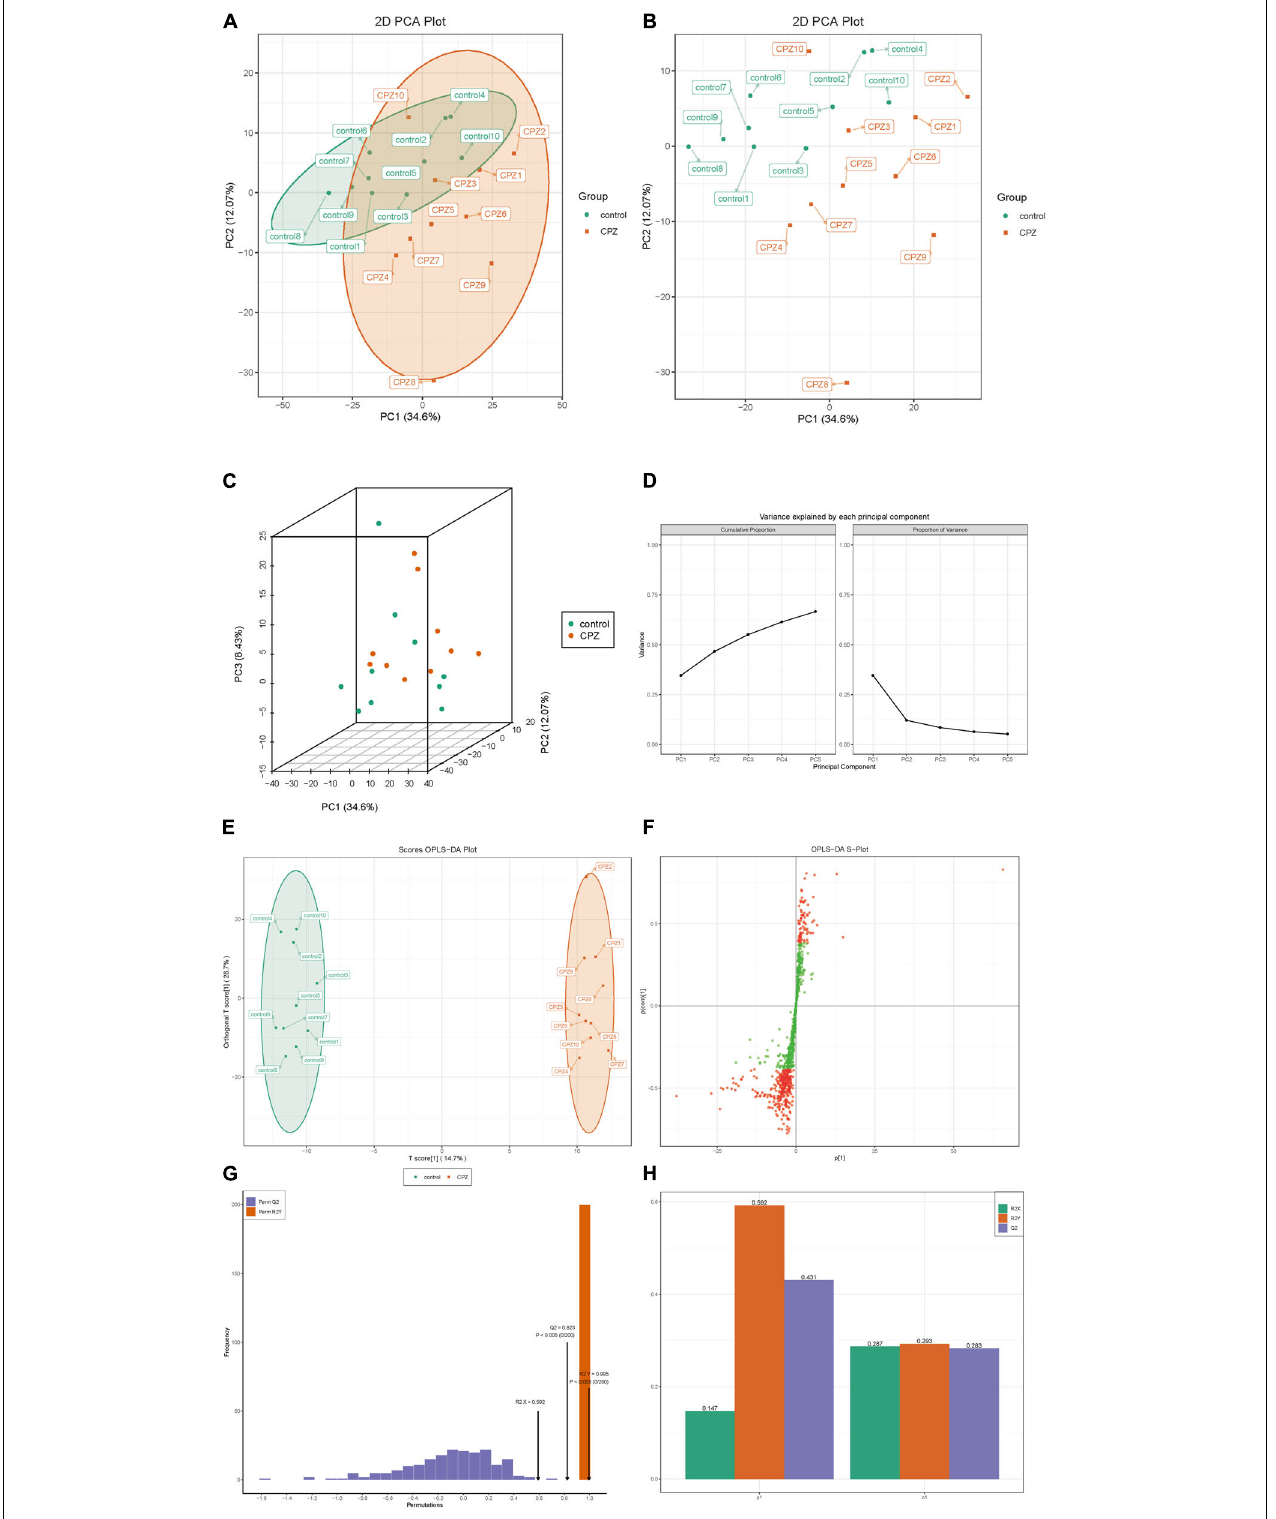
FIGURE 4 | (A,B) The two-dimensional images of the subgroup PCA analysis. (C) The 3D images of the subgroup PCA analysis. (D) The plot of variance explained by each principal component. (E) OPLS-DA score map. (F) S-plot of OPLS-DA. (G) Permutation test. (H) The details of the permutation test.